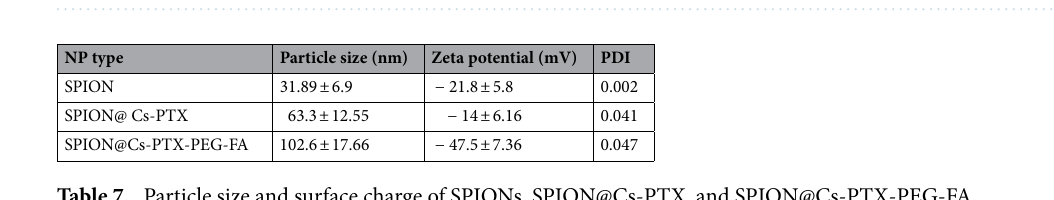
Figure 11. In the right illustrated: Particle-size distribution of ( a ) SPIONs, ( b ) SPION@Cs-PTX, and ( c ) SPION@Cs-PTX-PEG-FA. In the left illustrated: Zeta-potential charge measurement of ( d ) SPION, ( e ) SPION@ Cs-PTX, and ( f ) SPION@Cs-PTX-PEG-FA obtained by dynamic light scattering.